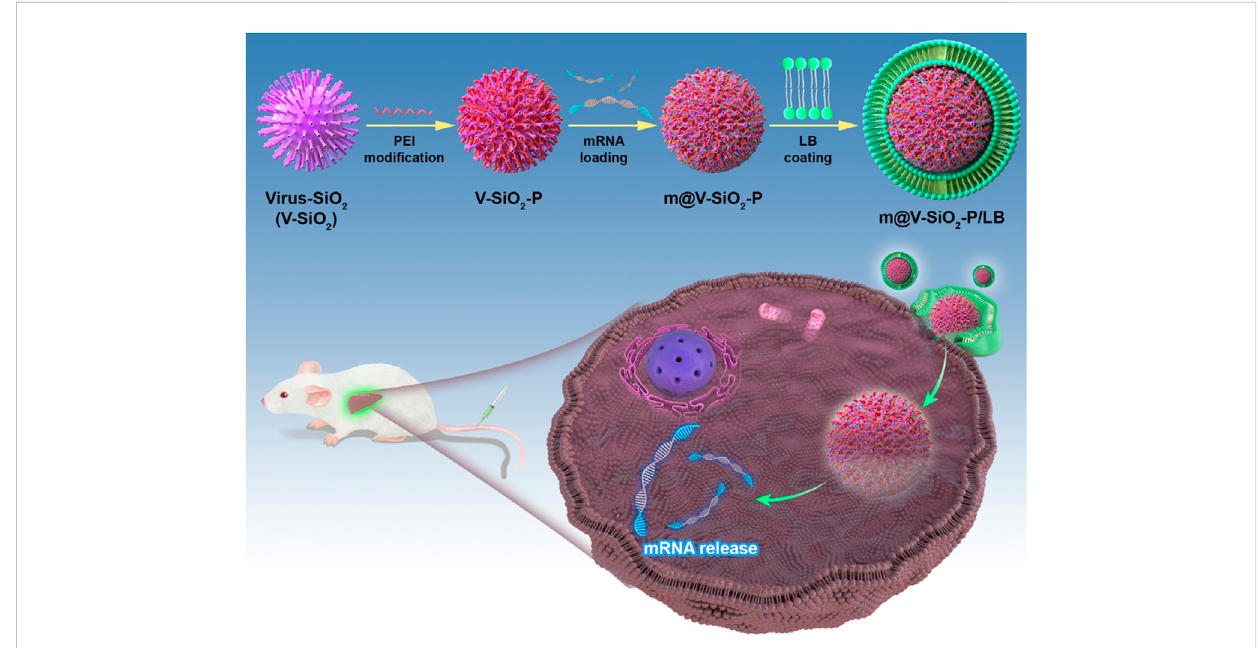
FIGURE 1 Schematic illustration. Novel bionic inspired nanosystem construction m@V-SiO 2 -P/LB nanosystem for Precise